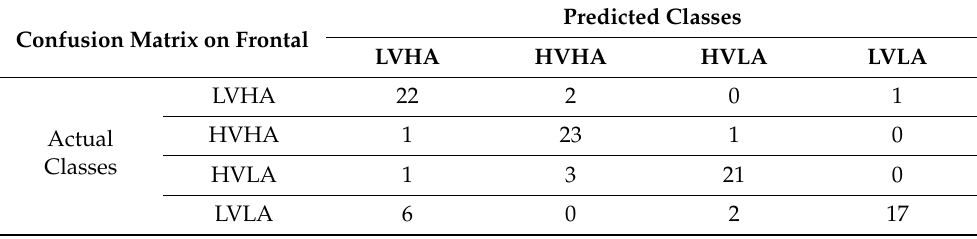
Table 4. The confusion matrix using average ERPs with one arousal and two valence